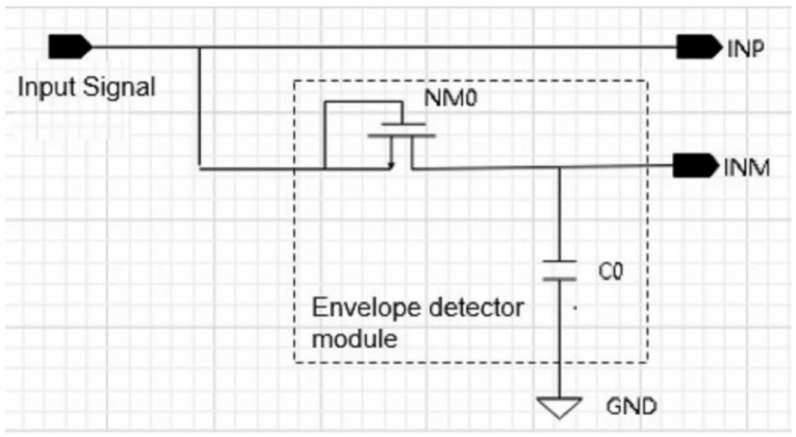
Figure 7. Envelope